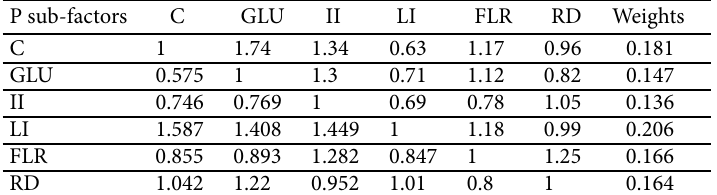
Table 7. Local weights and pairwise comparison matrix of physical sub-factors P sub-factors